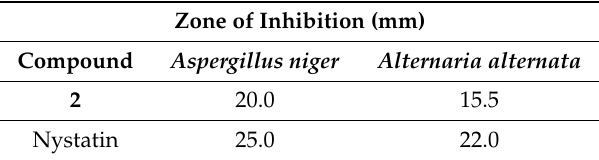
Table 4. Result of antifungal activity for compound 2 with respect to the standard (Disc diffusion method).